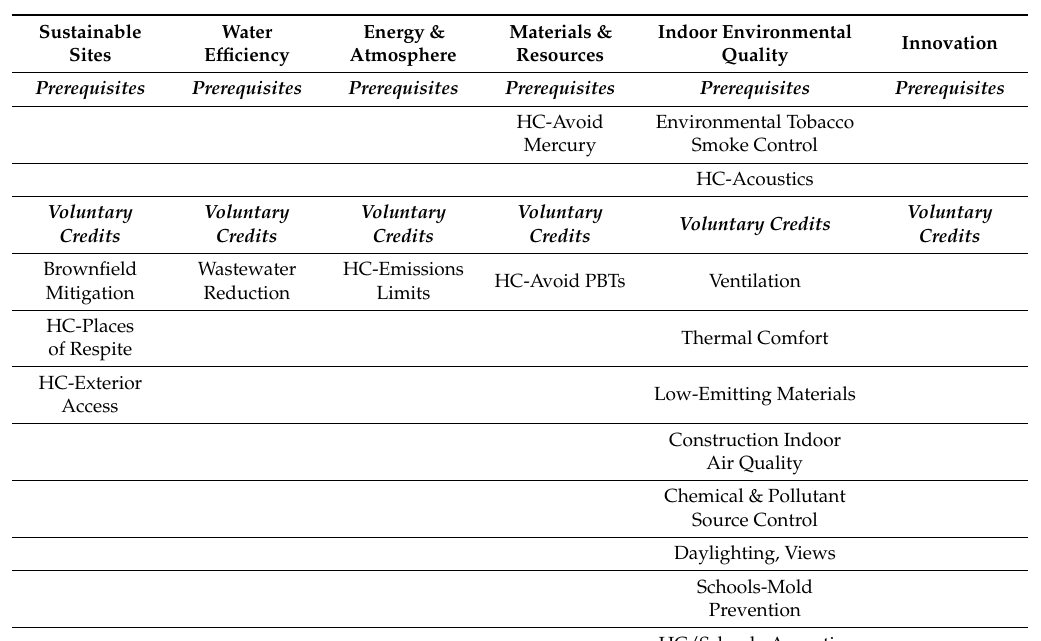
Table 1. Health-related prerequisites and credits in LEED version 2009 commercial rating systems by